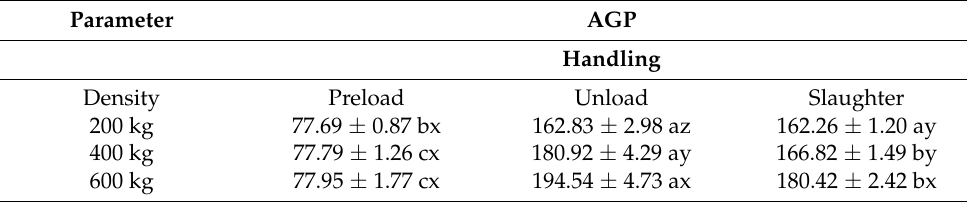
Table 6. Serum α -1 glycoprotein (AGP) as affected by the interaction between handling and stocking density in road transported cattle.